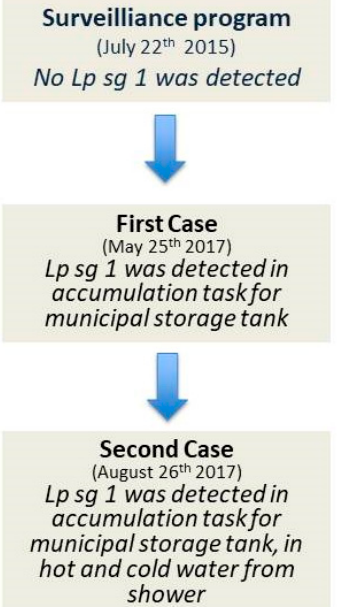
Figure 1. Data regarding a cluster in a Sicilian prison (1PA).